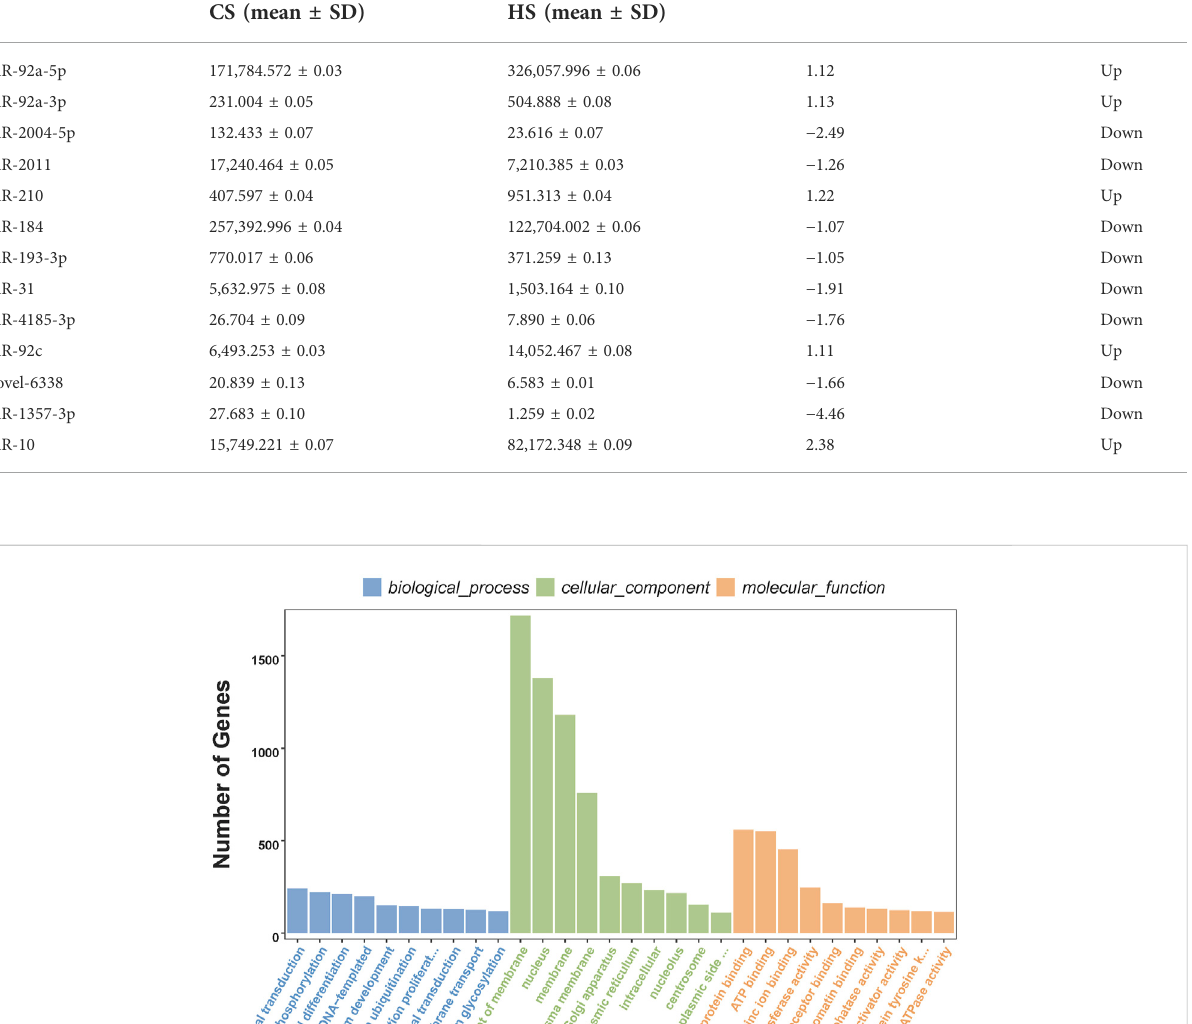
TABLE 3 Information of signi fi cantly differential expressed miRNAs in the body wall of Apostichopus japonicas under heat stress. miRNA ID